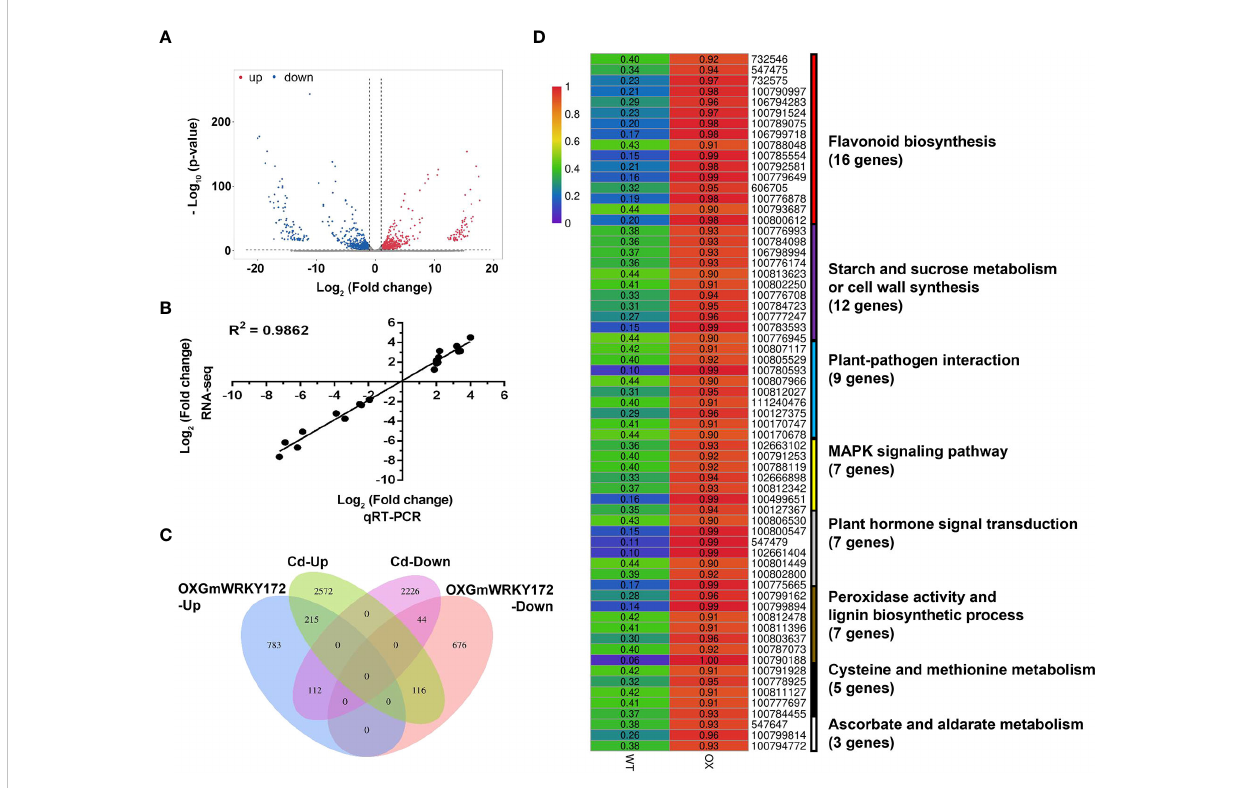
FIGURE 5 Overexpression of GmWRKY172 led to extensive transcriptional reprogramming of stress-responsive genes. (A) Scatter-plot graphs of the differential gene expression patterns between overexpressing lines and WT. Red represents up-regulated genes, while blue represents down-regulated ones. (B) Validation of expression patterns of 20 DEGs by qRT-PCR assay. The correlation is R 2 = 0.9862. (C) Venn diagram shows the overlap of GmWRKY172 overexpression and Cd-induced DEGs. (D) The Cd responsive KEGG pathways among the differentially expressed